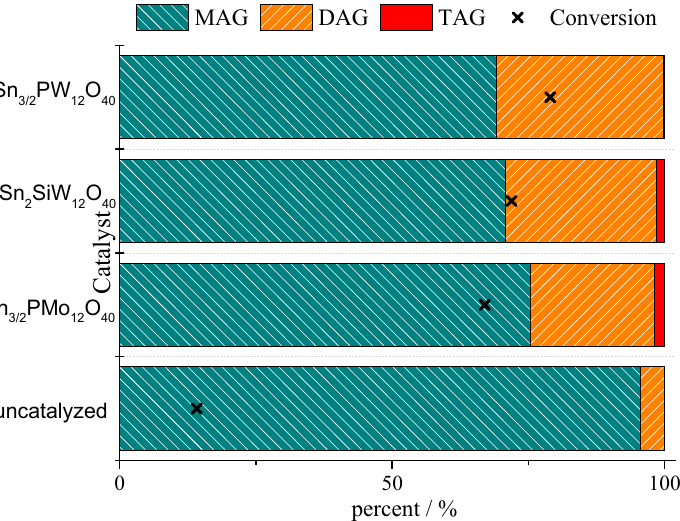
Figure 17. Tin-heteropoly-salt-catalyzed reactions: effect of the anion (adapted from ref. [57]). Reaction conditions: glycerol (24.0 mmol); HOAc (72.0 mmol); temperature (333 K); catalyst (0.10 mol % Sn 2+ ); volume (10 mL). The Sn 3/2 PW 12 O 40 was the most active and selective toward MAG and DAG. Aiming to enhance the performance of the Sn 3/2 PW 12 O 40 catalyst, the authors thermally treated the stannous phosphotungstate salt. The main results are depicted in Figure 18.